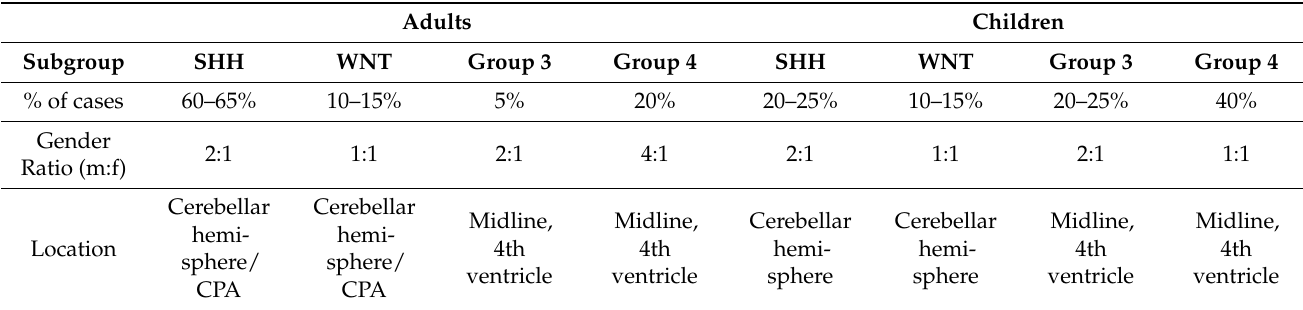
Table 1. Characteristics for the molecular subgroups of adult and pediatric medulloblastoma, based on data from the following references [2,7–9,11,13,18,21–25,27–30]. Abbreviations: CPA = cerebellopontine angle, SHH = sonic hedgehog, WNT = wingless, OS = overall